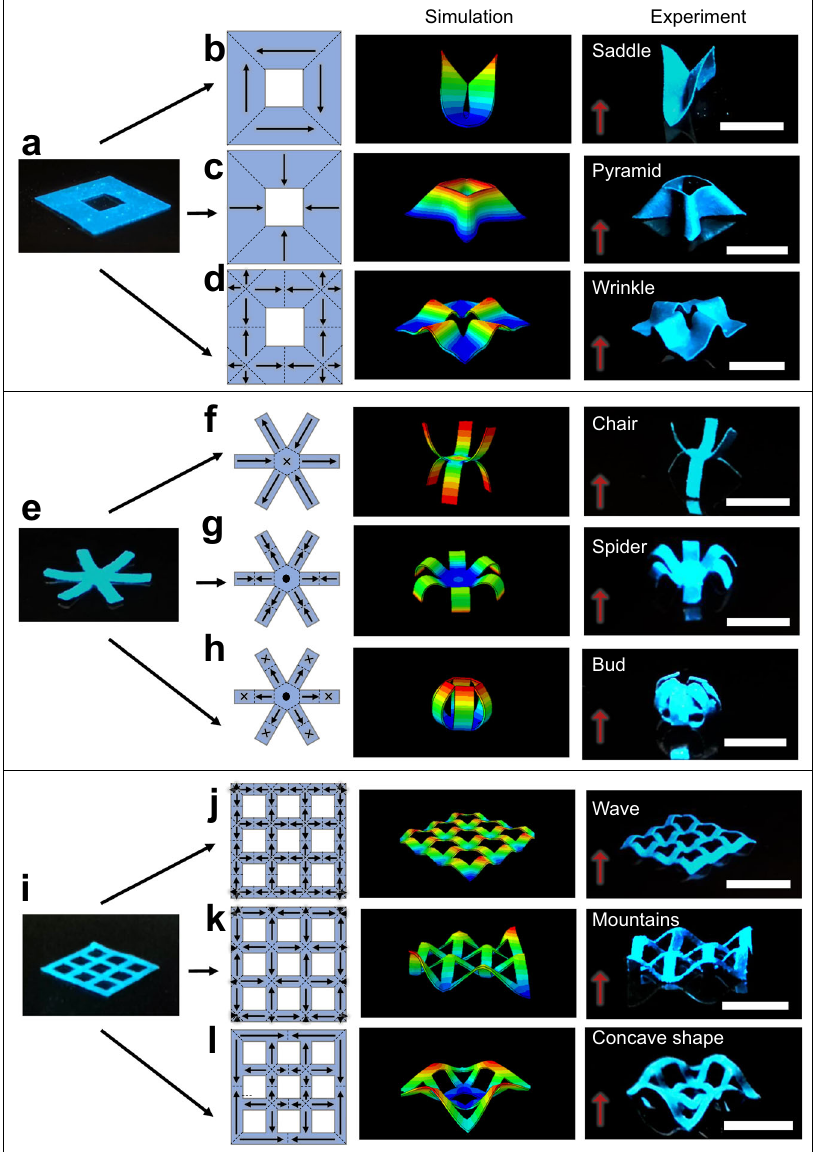
Fig. 3 Demonstration of complex 3D shaping under magnetic actuation of MRSM origami fi lms with reprogrammable magnetization patterns. Schematic of magnetization patterns, FEA predictions and optical images of morphed 3D structures from a square-hollow MRSM fi lm ( a – d ), a six-armed MRSM fi lm ( e – h ) and a mesh-shaped MRSM fi lm ( i – l ). The magnetic fi lms are actuated under a magnetic fi eld of 150 mT, which is perpendicular to the fi lms as indicated by the red arrow. Scale Bars: 5 Fig. 5b is programmed. With such a magnetization pattern, the Petal 1 and Petal 3 bend to connect partial circuit to turn on LED 1 and LED 3 upon the actuation of a perpendicular magnetic fi eld (150 mT). Once the actuation magnetic fi eld is applied in the opposite direction, Petal 2 and Petal 4 connect the electrodes and switch on LED 2 and LED 4 (Supplementary Movie 7). After the magnetic anisotropy in the petals of this MRSM switch is reprogrammed, e.g., making the opposite magnetization direc- tions of Petal 1 and Petal 2, the switch can yield a different switching function. By subsequently changing the magnetic directions of the actuation magnetic fi eld, LED 1/LED 4 and LED 2/LED 3 can be subsequently turned on (Fig. 5c).